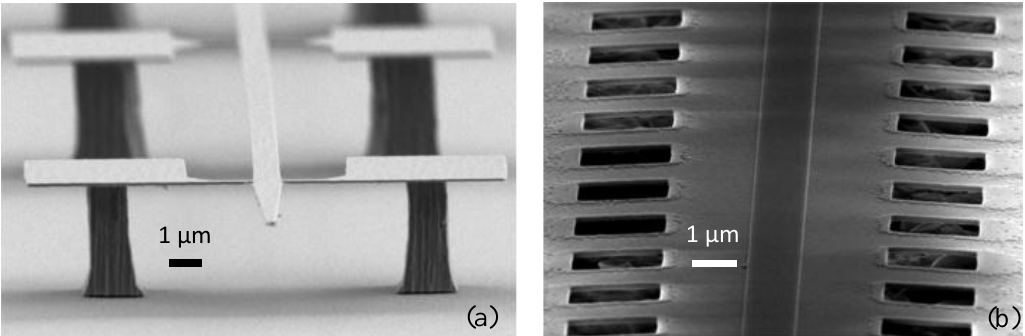
Figure 2. Scanning electron microscope (SEM) images of the suspended nanowire ( a ) and nanorib ( b ) waveguides.